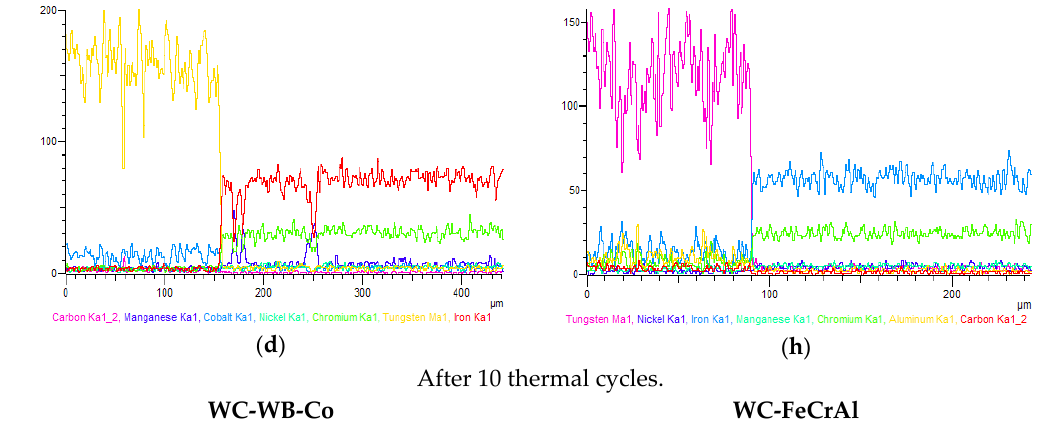
Figure 8. ( a ) SEM image of WC-WB-Co coating; EDX line scan of ( b ) as-sprayed WC-WB-Co coating; ( c ) after 5 thermal cycles; ( d ) after 10 thermal cycles; ( e ) SEM image of WC-FeCrAl coating; EDX line scan of ( f ) as-sprayed WC-FeCrAl coating; ( g ) after 5 thermal cycles; ( h ) after 10 thermal cycles.